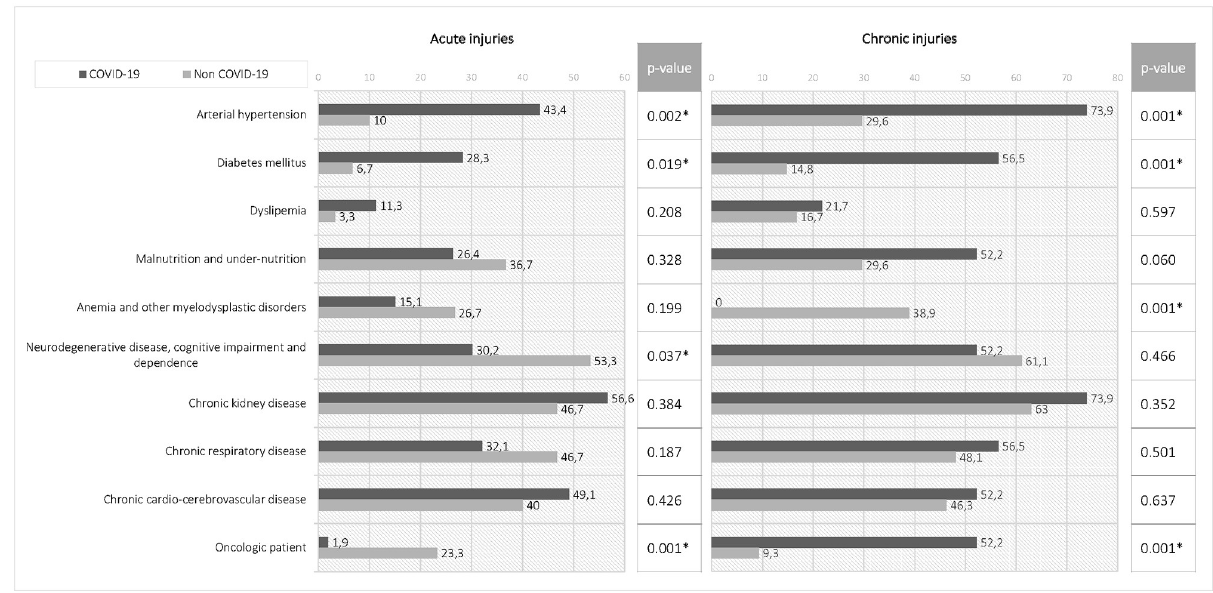
Fig 4. Percentage distribution comorbidity in acute injuries vs. chronic injuries and p-values obtained for the observed difference between the paired samples.